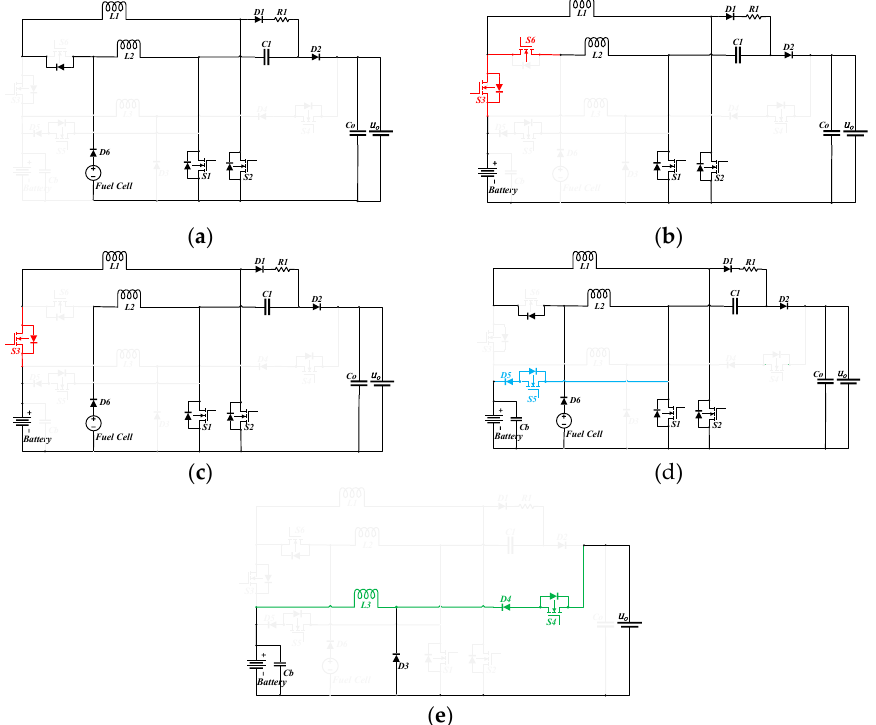
Figure 2. Equivalent circuits of five different operating states: ( a ) State 1; ( b ) State 2; ( c ) State 3; ( d ) State 4; ( e ) State 5.